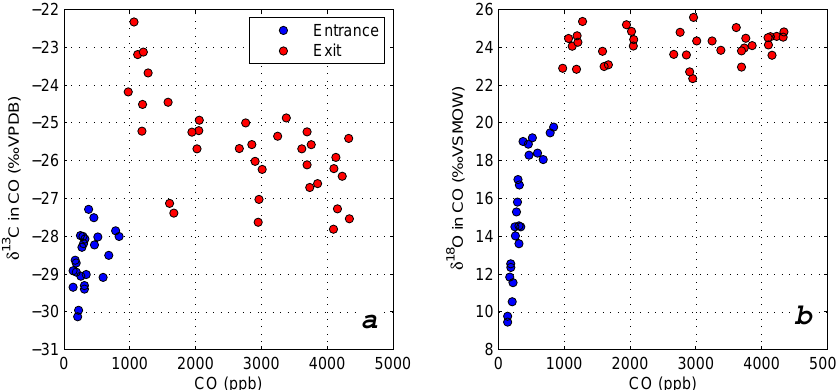
Fig. 4. δ 13 C in CO (a) and δ 18 O in CO (b) , with entrance and exit data shown in blue and red colours respectively. Two data points with CO around 10000ppb are not shown.